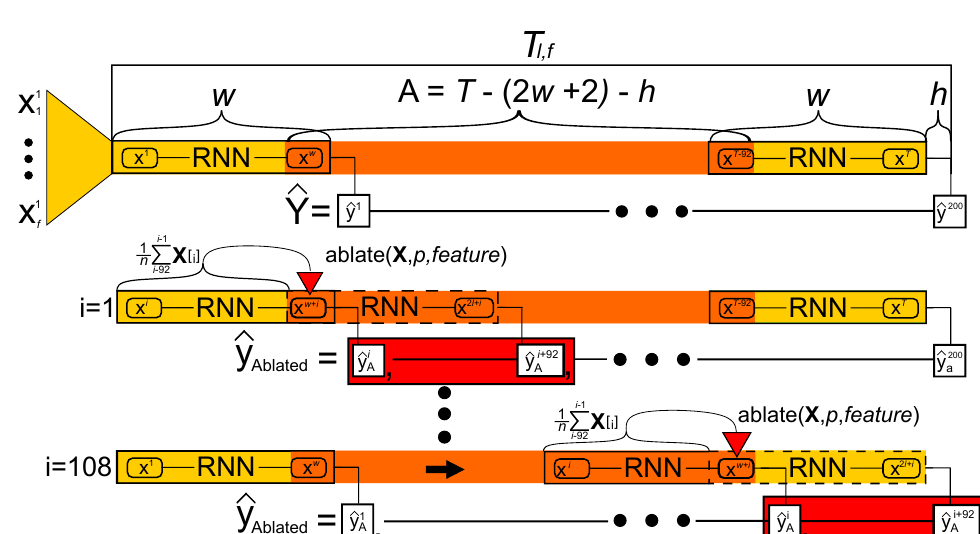
Figure 3. Overview of the ablation method on the test dataset. The time series T comprises an ablation area (orange), a prediction horizon ( h ), and two flanking regions (yellow) of size w where l is the sequence length of the RNN models. As the models slides over, T predictions that differ from the ˆ y due to inclusion of the ablated input are noted